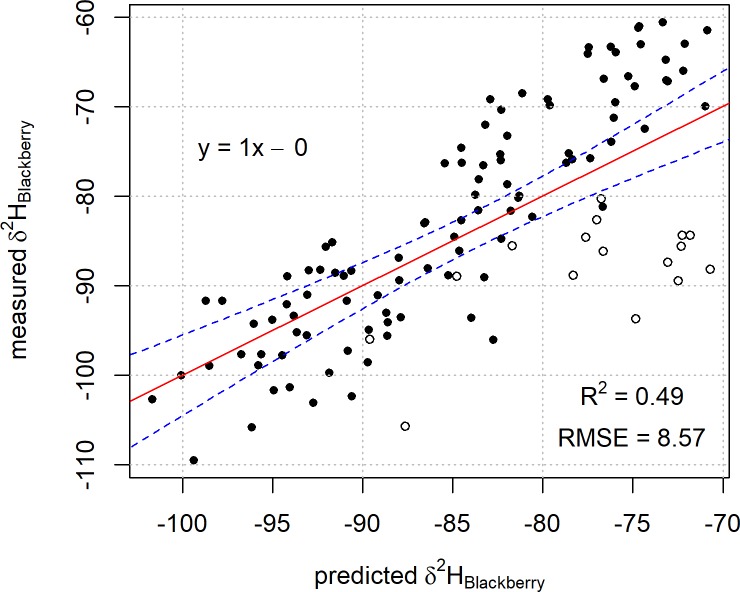
Plot of predicted blackberry leaf δ2H values based on Model 1 against the measured blackberry leaf δ2H values.The linear regression line of best fit is represented by the red line with 99% confidence intervals for the fit in blue. Samples from the West Coast region of the South Island are represented by open circles (○).